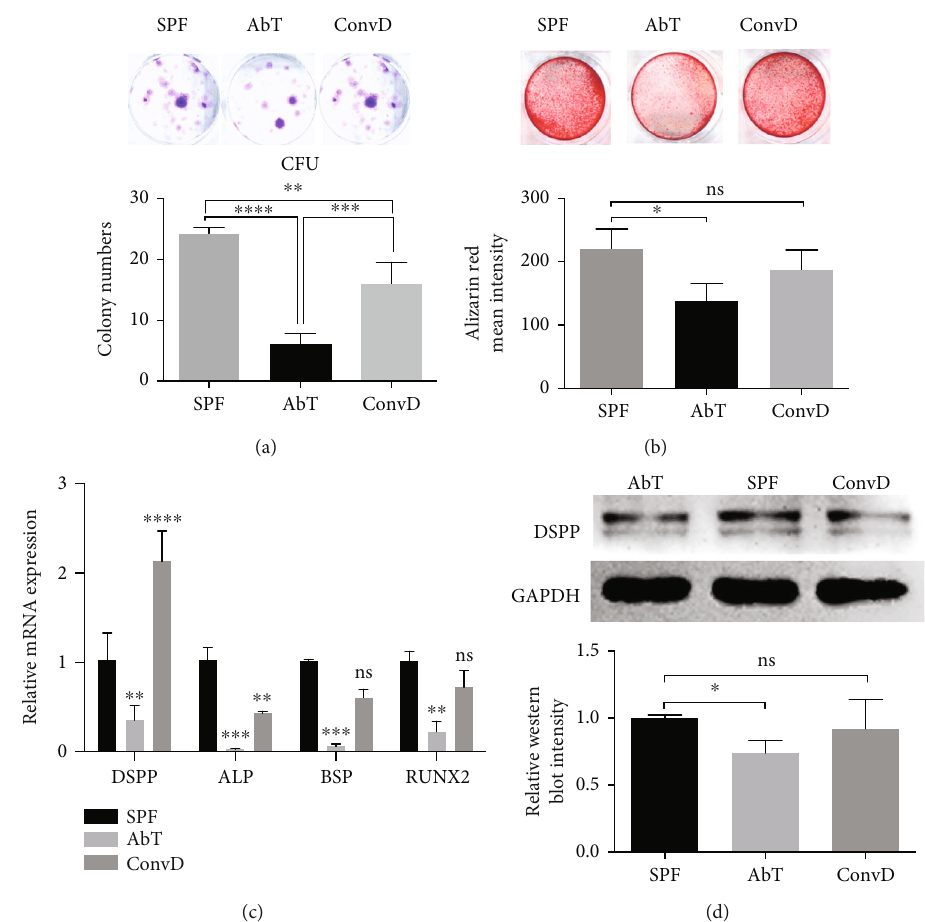
Figure 3: DPSCs from AbT mice exhibited impaired colony-forming ability and mineralized potential. (a) Colony-forming unit experiments showed that DPSCs derived from AbT mice had lower colony-forming rate compared to those from SPF and ConvD mice. (b) Alizarin red staining showed that AbT-derived DPSCs formed less mineralized nodule in vitro compared to SPF and ConvD groups. (c) Real-time PCR results showed that SPF-DPSCs exhibited higher expression of mineralization relative mRNA. (d) Western blot analysis showed that AbT- DPSCs expressed lower DSPP after osteo-/odontogenic induction in vitro . All experimental data were veri fi ed in at least three independent experiments. Error bars represent the SEM from the mean values. ∗∗∗∗ P < 0 : 0001 ; ∗∗∗ P < 0 : 001 ; ∗∗ P < 0 : 01 ; ∗ P < 0 : 05 . AbT: antibiotic treated; ConvD: conventionalized; SPF: speci fi c pathogen-free; DSPP: dentin